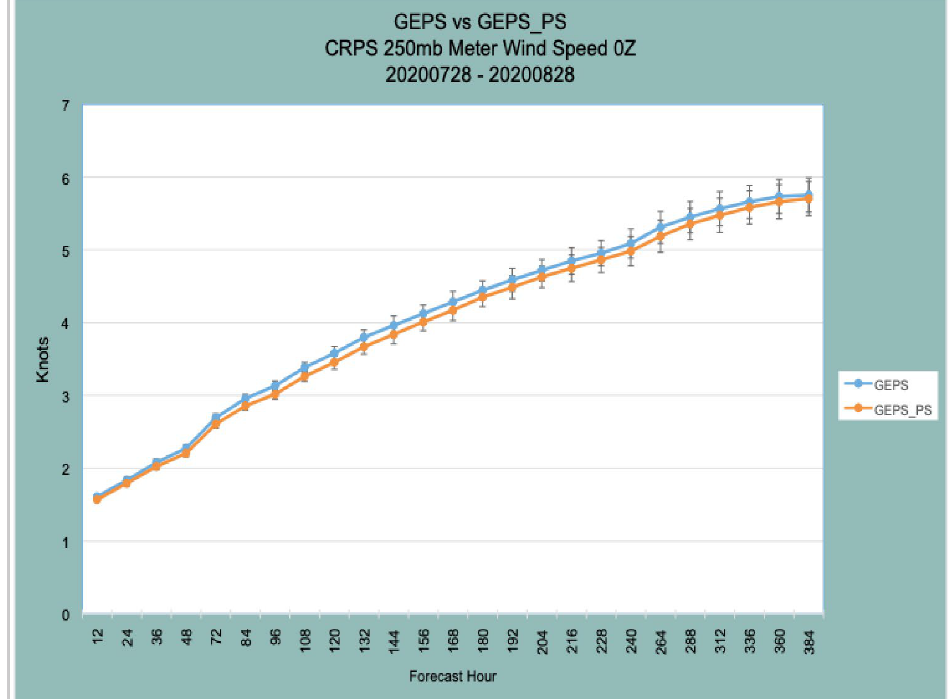
Figure 22. Continuous Ranked Probability Scores for GEPS (blue) and GEPS with GALWEM-GE included (orange) for 250 hPa wind speed as compared to the corresponding UM analysis for the period 28 July 2020 through 28 August 2020. Error bars represent the 95% confidence interval for the CRPS values.